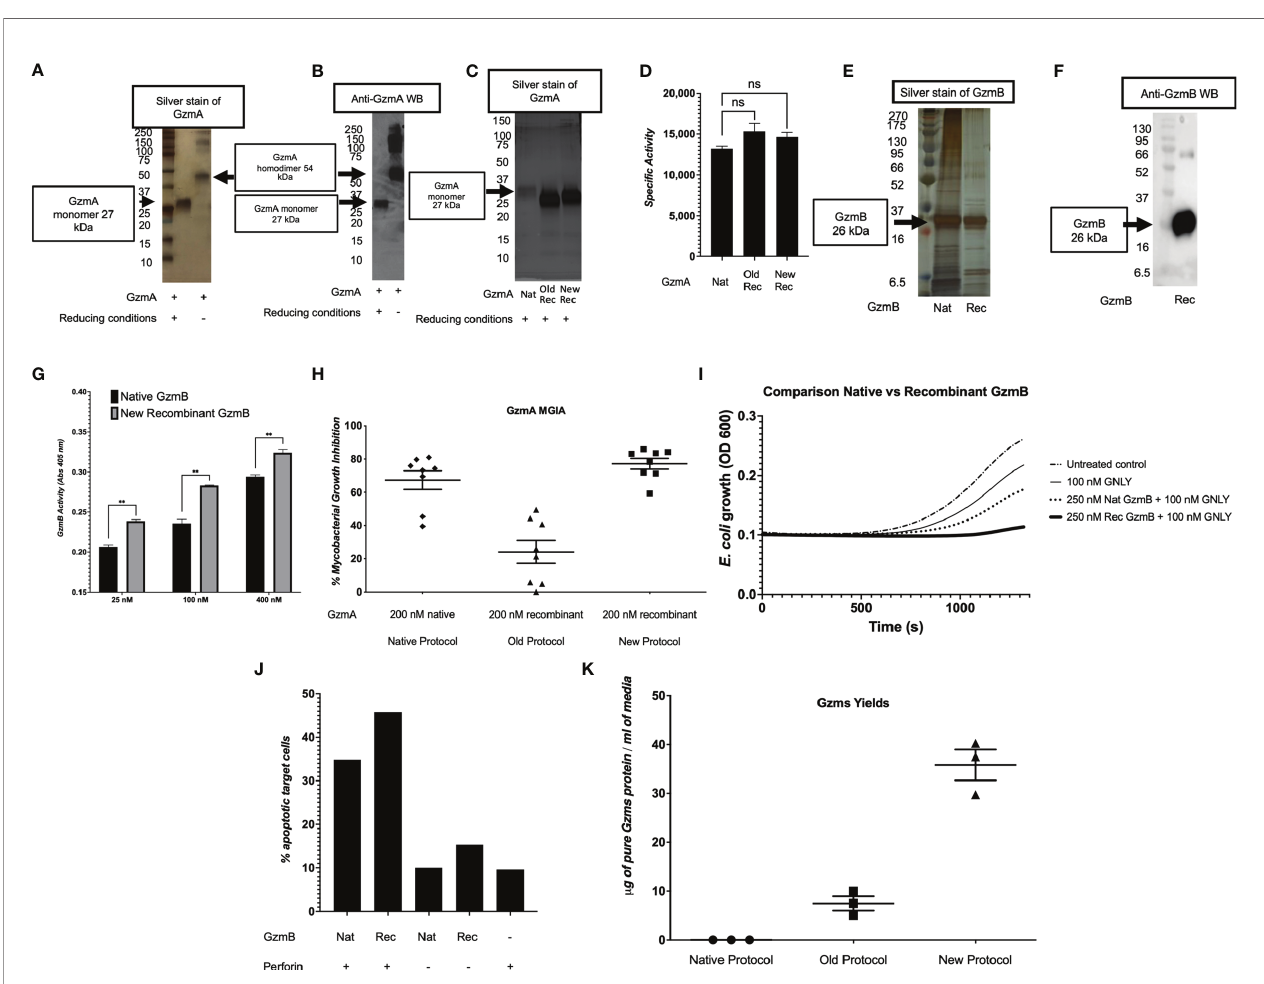
FIGURE 4 | Purity and yield of Gzms. GzmA purity was assessed by silver stain (A) and Western Blot (WB) (B) under reducing conditions showing GzmA monomer at 27 kDa, and non-reducing conditions showing GzmA homodimer at 54 kDa. Under non-reducing conditions, GzmA homodimer and multimers are present. On the left, MW markers. (C) Silver stain comparing Native GzmA [puri fi ed per (35)], Recombinant GzmA puri fi ed using old protocol vs new protocol under reducing conditions. Monomer band shows at around 27 kDa and on the left MW markers. (D) Speci fi c activity of GzmA after analyzing the enzyme kinetics at cleaving substrate BLT and comparison between native, old protocol rec GzmA and new protocol rec GzmA (data representative of three independent experiments; ns calculated using student t test; means and SD). (E, F) present similar purity results for GzmB and comparisons between native (puri fi ed per [35)] and new recombinant puri fi cation (GzmB runs at 27 kDa). On the left, MW markers. (G) Comparison of native vs new recombinant GzmB ’ s enzymatic activity as measured by cleavage of AAD at different protein concentrations (n=3 independent experiments, mean and SD, student t test). (H) GzmA-mediated functional potency as measured by the MGIA, and comparison between proteins puri fi ed with the native method, the old recombinant method, and the new recombinant method (n=8 human subjects, data representative of at least two independent experiments; means and SEM). (I) GzmB suppresses extracellular E.coli growth after delivery into bacteria with added GNLY (averaged data representative of at least two independent experiments). (J) Background adjusted percentage of apoptotic cells as measured by Annexin V and PI staining after incubation of proteins with Jurkat cells (n=2, mean). (K) Comparison of yields of Gzms (GzmA and GzmB) between native, old, and new protocols (data representative of multiple independent puri fi cations involving different operators and sites; means and